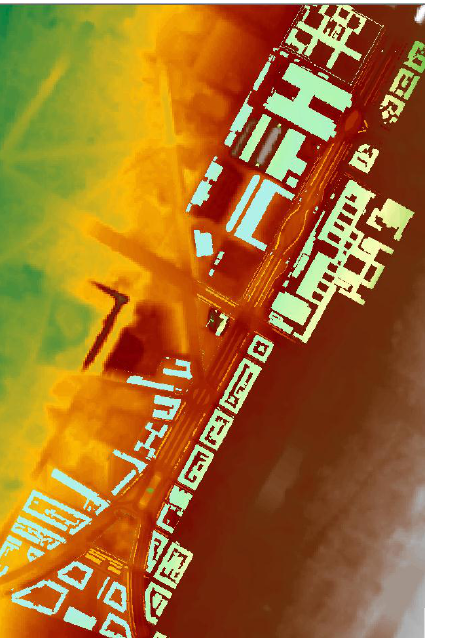
Figure 3. DSM of the test site